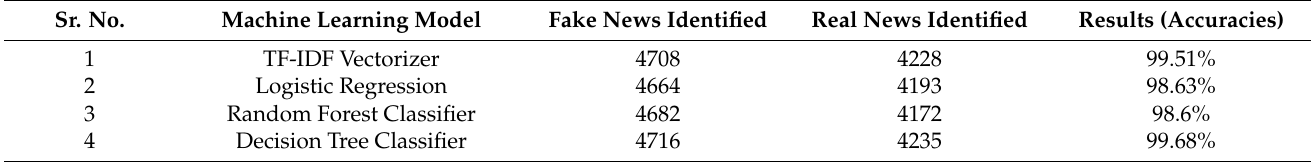
Table 3. Accuracies after applying machine learning models before cleaning.